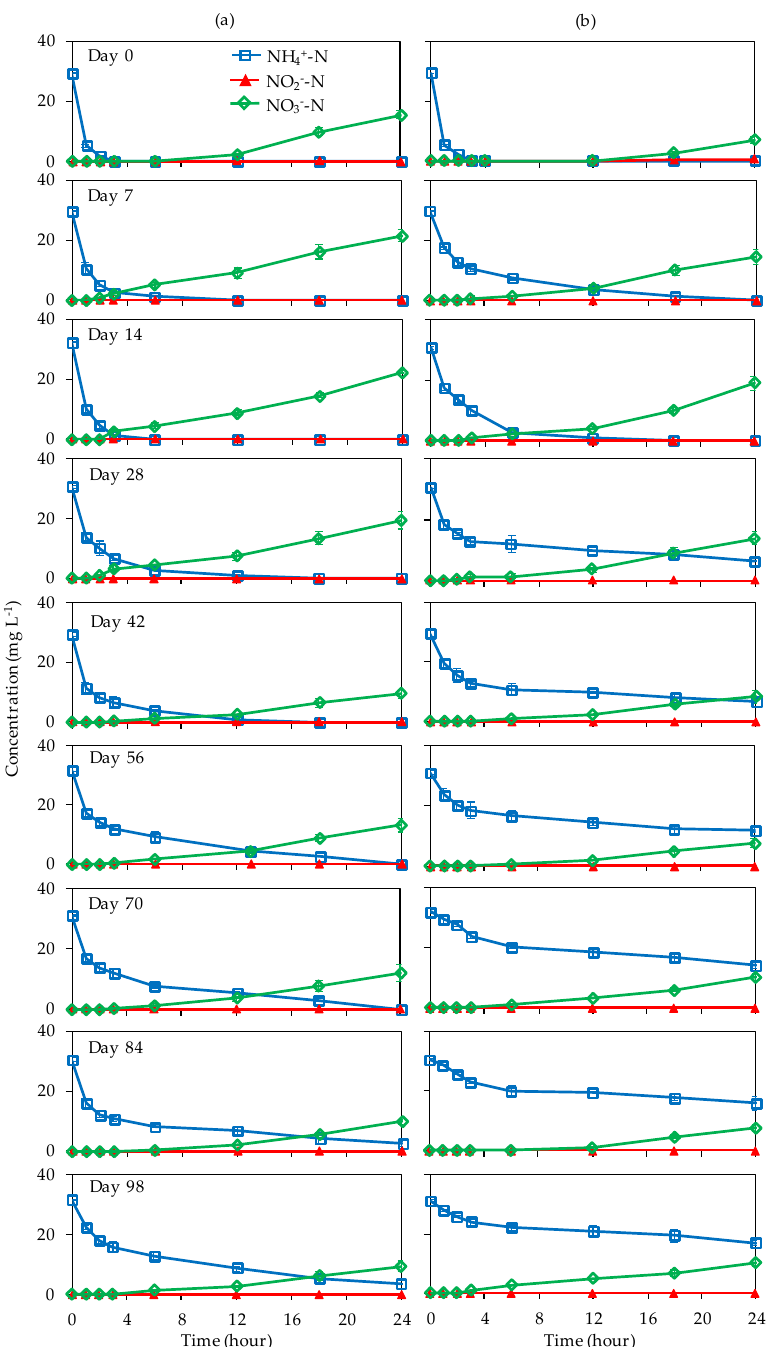
Figure 3. N removal potential of zeolite-microbe association in ( a ) tidal flow CWs, and ( b ) continuous flow CWs. Values are means ± SD (n = 3).